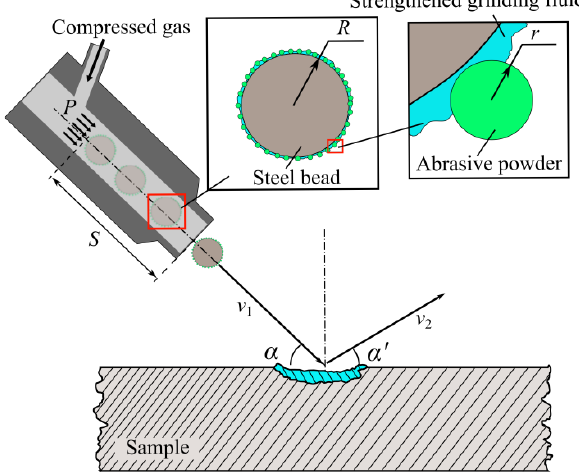
Figure 12. Schematic view of impact principle.